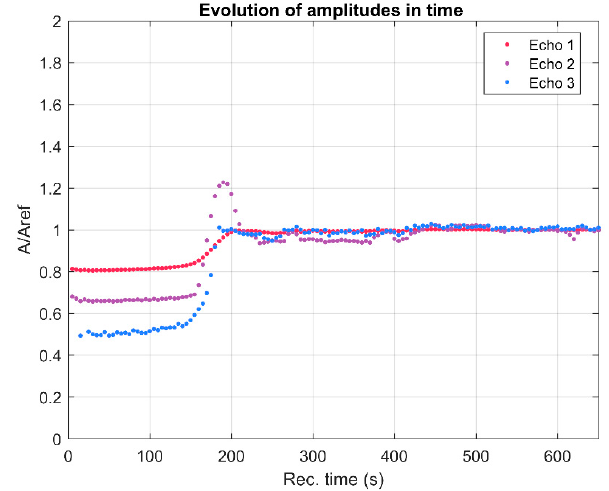
Figure 3. Relative amplitudes evolution vs. the recording moments.